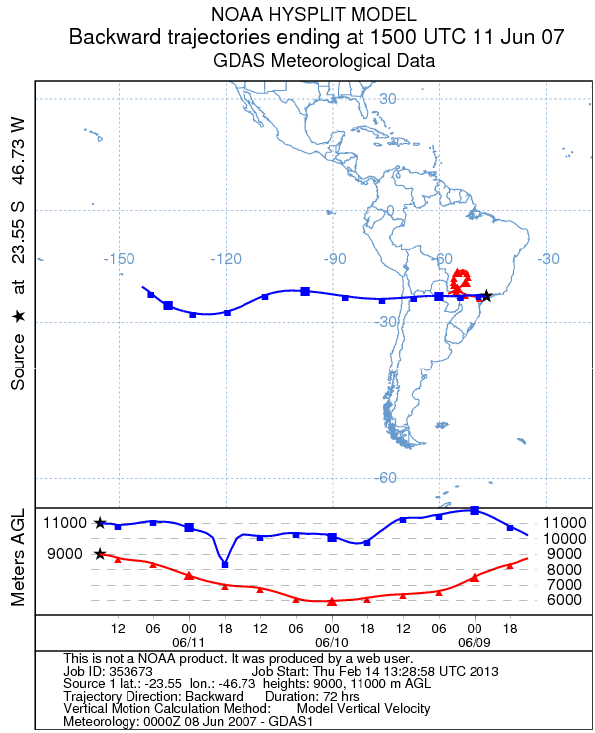
Fig. 2. NOAA HYSPLIT model backward trajectories ending at 15:00UTC on 11 June 2007 corresponding to the city of São Paulo (23 ◦ 33 0 S, 46 ◦ 44 0 W) showing the origin of air masses for the re- spective altitudes ( ∼ 9km and 11km) where cirrus clouds were de- tected by the MSP-lidar. The sequence of ending time was chosen on purpose to coincide with the period when two distinct cirrus lay- ers were observed in Fig. 1, indicating here different